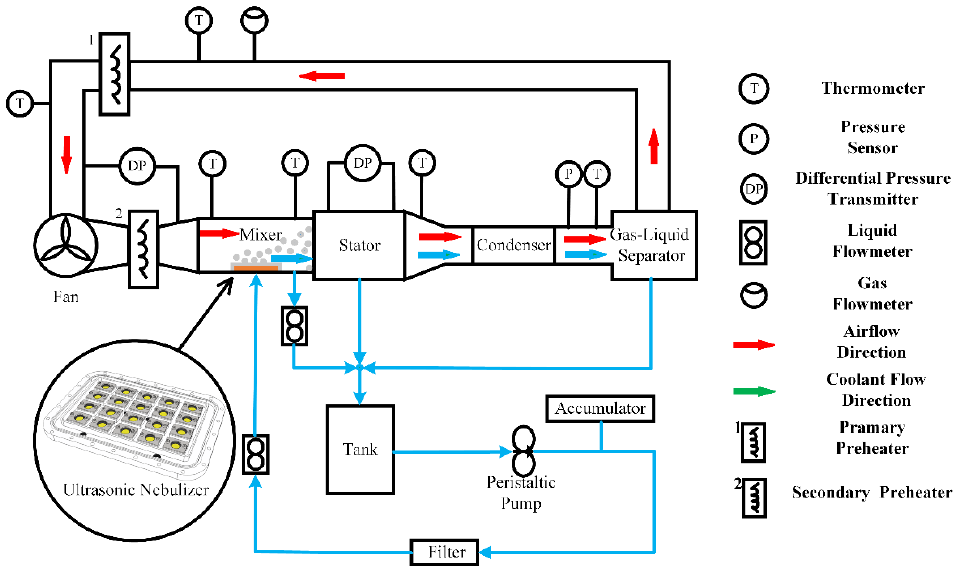
Figure 2. The schematic diagram of the experimental platform.